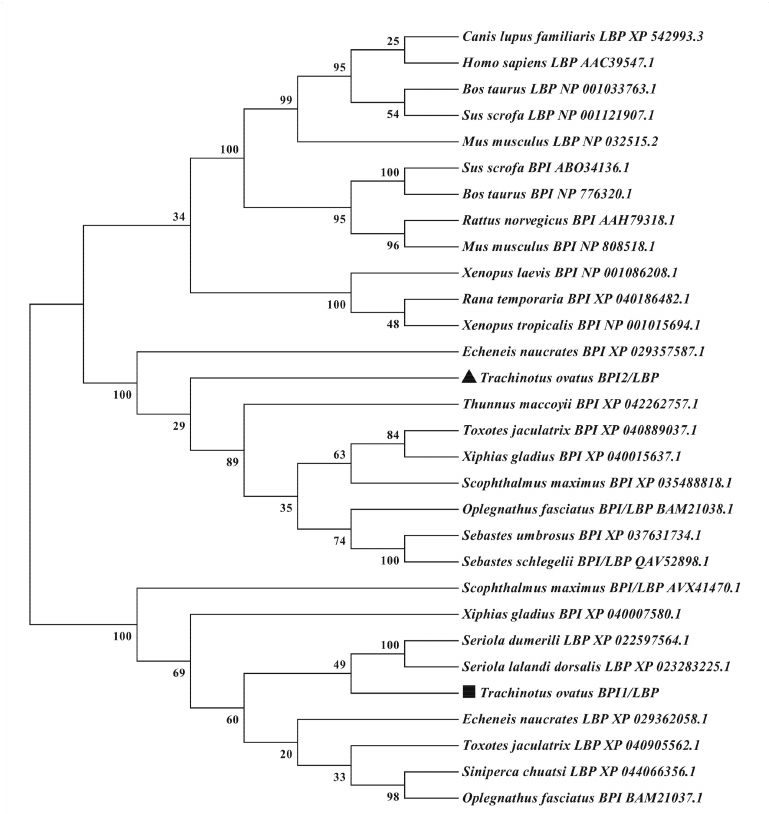
Figure 3. The amino acid sequences of ToBPI1/LBP and ToBPI2/LBP were compared with the known sequences of BPI, LBP and BPI/LBP from other species. The NJ method was used to construct an evolutionary tree. Boot the NJ tree 1000 times to check the repeatability of the results. ToBPI1/LBP is denoted by a black square, and ToBPI2/LBP is indicated by a black triangle.